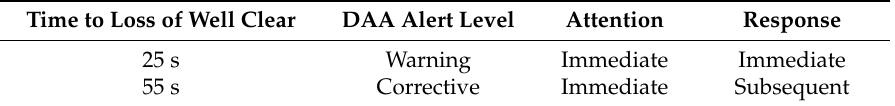
Table 3. Alerting criteria in DAA of